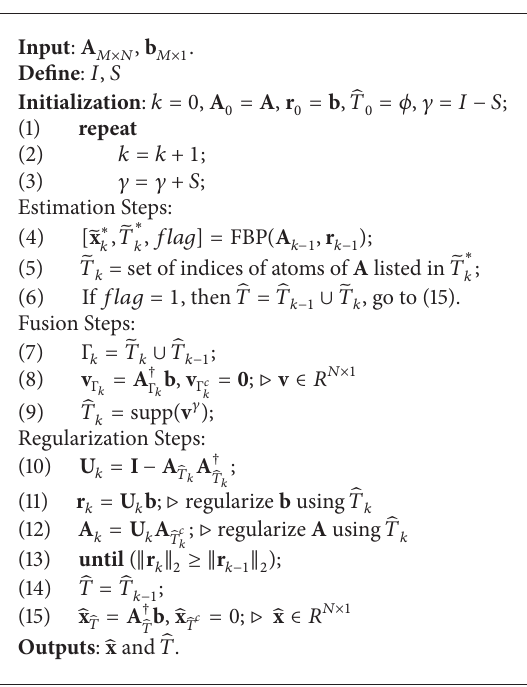
Algorithm 2: IFBP